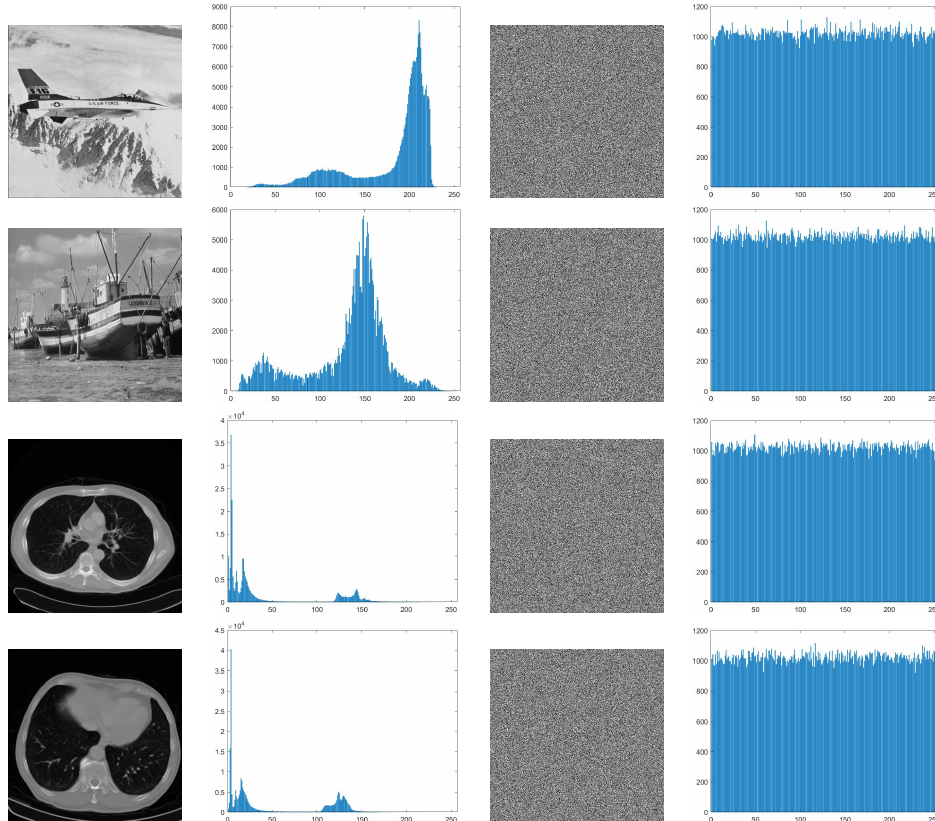
Figure 11. Histogram analysis of the final encrypted images.